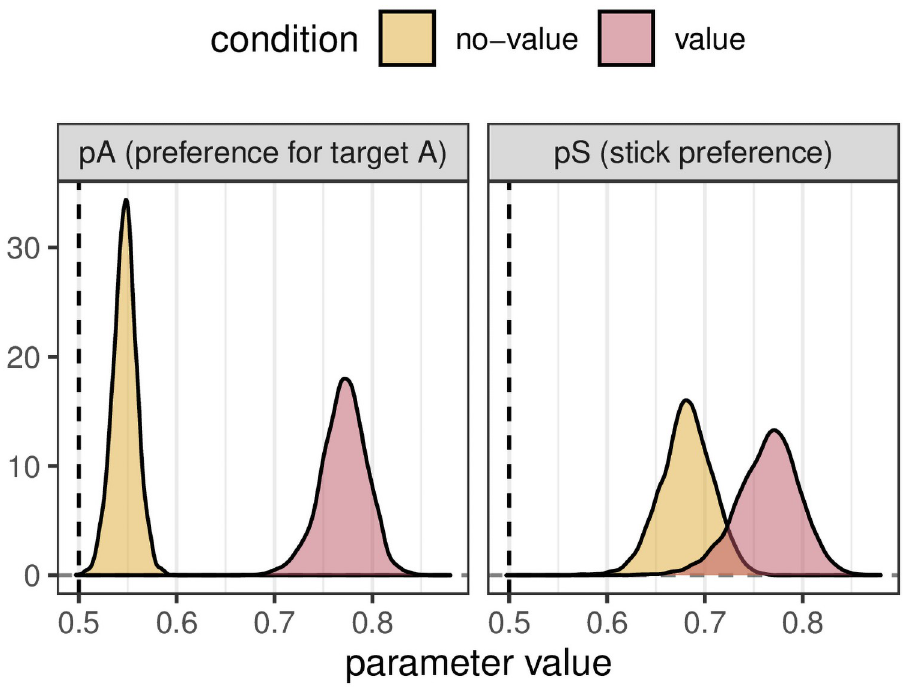
Fig 5. p and p biases across participants in multi-level re-analysis of Tagu and Kristja´nsson (2021), showing both a s the value and no-value